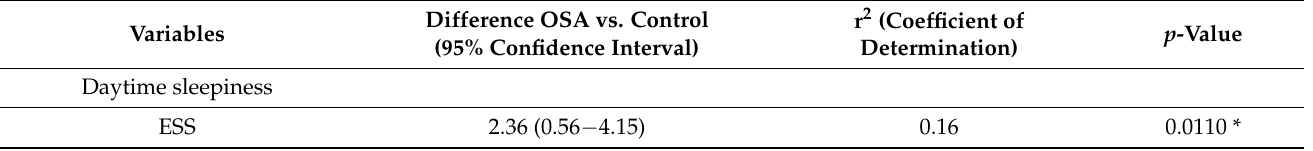
Table 1. Differences in daytime sleepiness and quality of life between the OSA group and the control group before MAD treatment. The estimates are shown with 95% confidence intervals, p -values and coefficients of determination (r 2 ). Adjusted for sex and